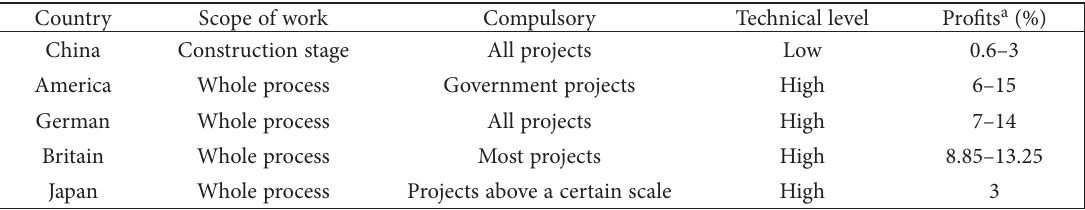
Table 1. Differences of the CSE in various